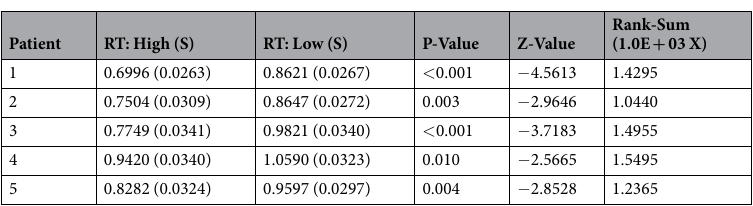
Table 2. Patients’ mean response times (in seconds) and the standard deviations in parentheses for each temporal context condition (high or low expectation) and the statistical difference between the two conditions indicated by two-sided Wilcoxon rank sum